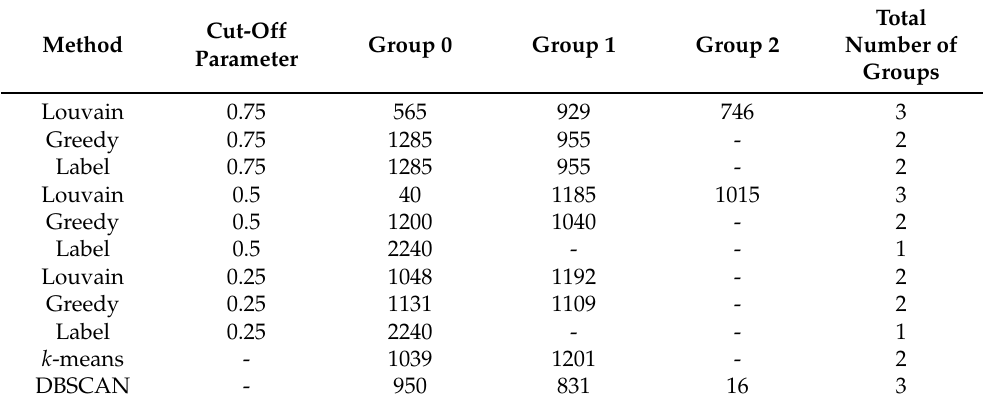
Table 6. Total number of groups and group sizes for each method (retail